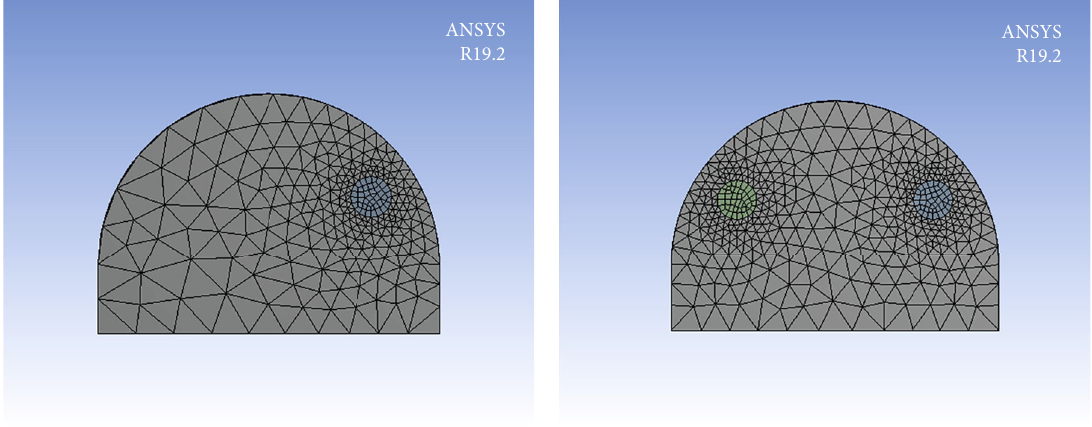
Figure 2: Schematic diagram of model